Question: What caption would you write for this figure?
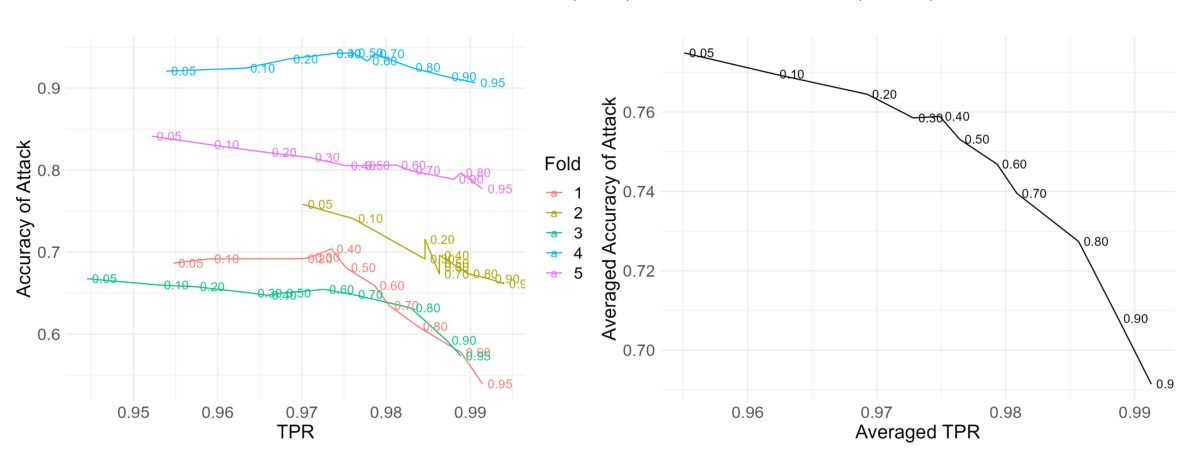
Answer: TPR versus Accuracy of Attack across Thresholds {0.05, 0.1, 0.2, . . . , 0.8, 0.9, 0.95} (la- beled next to the lines) for PD Plots of Age, COMPAS Data